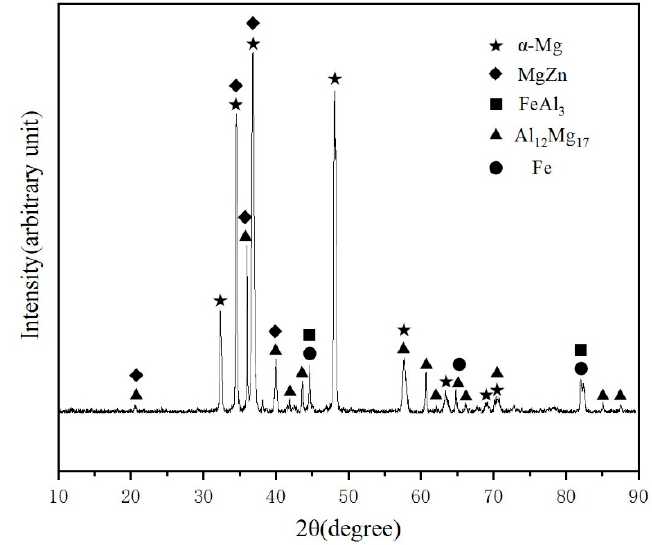
Figure 8. XRD diffraction pattern of the cross-section of galvanized-steel/AZ91D bimetallic material.